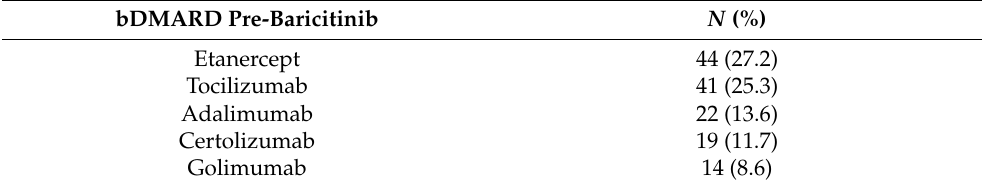
Table 3. bDMARDs prescribed to established patients ( N = 162) during the pre-ID period in the baricitinib cohort.